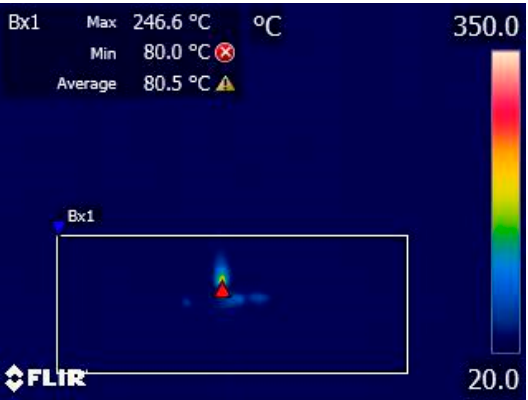
Figure 5. Drilling temperature image (AlTiN-coated, speed of 20 m/min, feed speed of 0.04 mm/r).